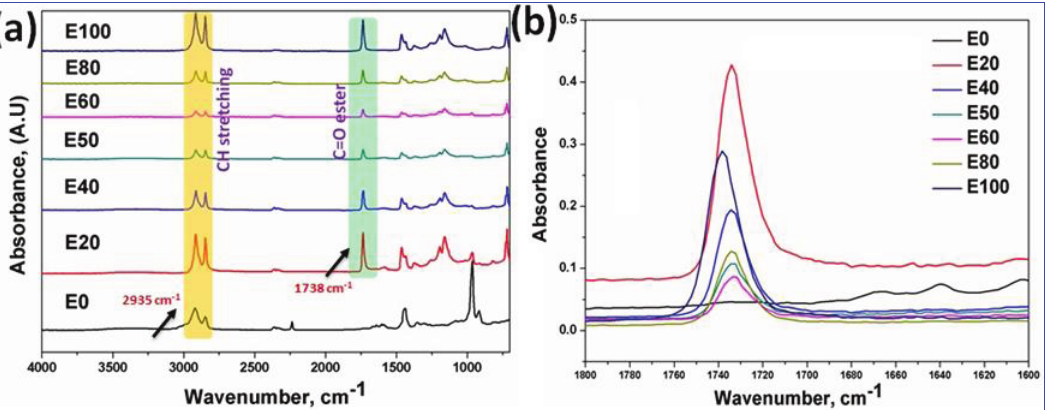
Figure1: (a) FTIR spectra of pristine EMA, NBR and their blends and (b) C=O stretching region of the various EMA/NBR blends with different compositions.